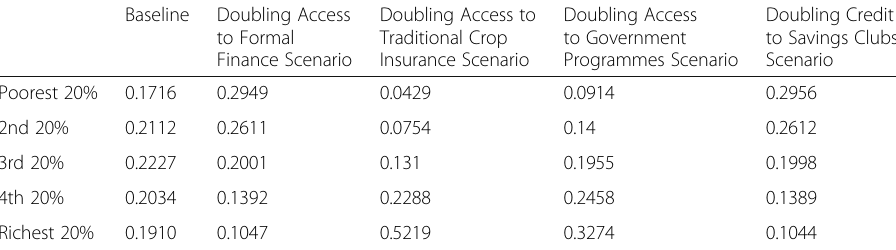
Table 3 Baseline and Predicted Probability Values for Access to Financial Services and Benefit across Quintiles